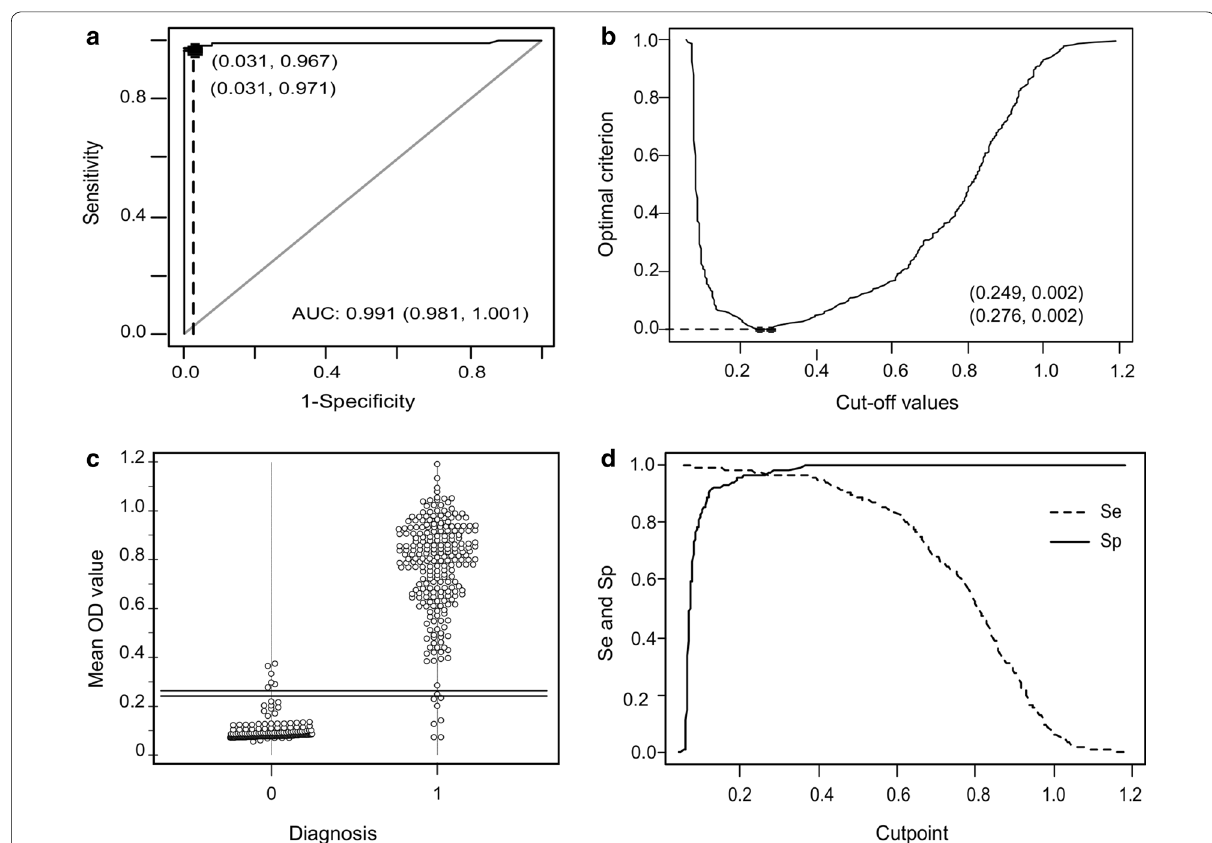
Fig. 4 Graphical analysis of the cut off value, Se and Sp for the ELISA-SVP. a ROC curve. Numbers in brackets in the upper left corner corresponds to 1 minus Sp and Se values for the resulting cutoffs. b Cut off values obtained using Se difference at the optimal cutoff. c Dot diagram for the 432 reference samples, 240 positives (code the in-house ELISA-SVP. The lines represent the cut off values (0.249 and 0.276 OD values). d Sensitivity and specificity plots according to